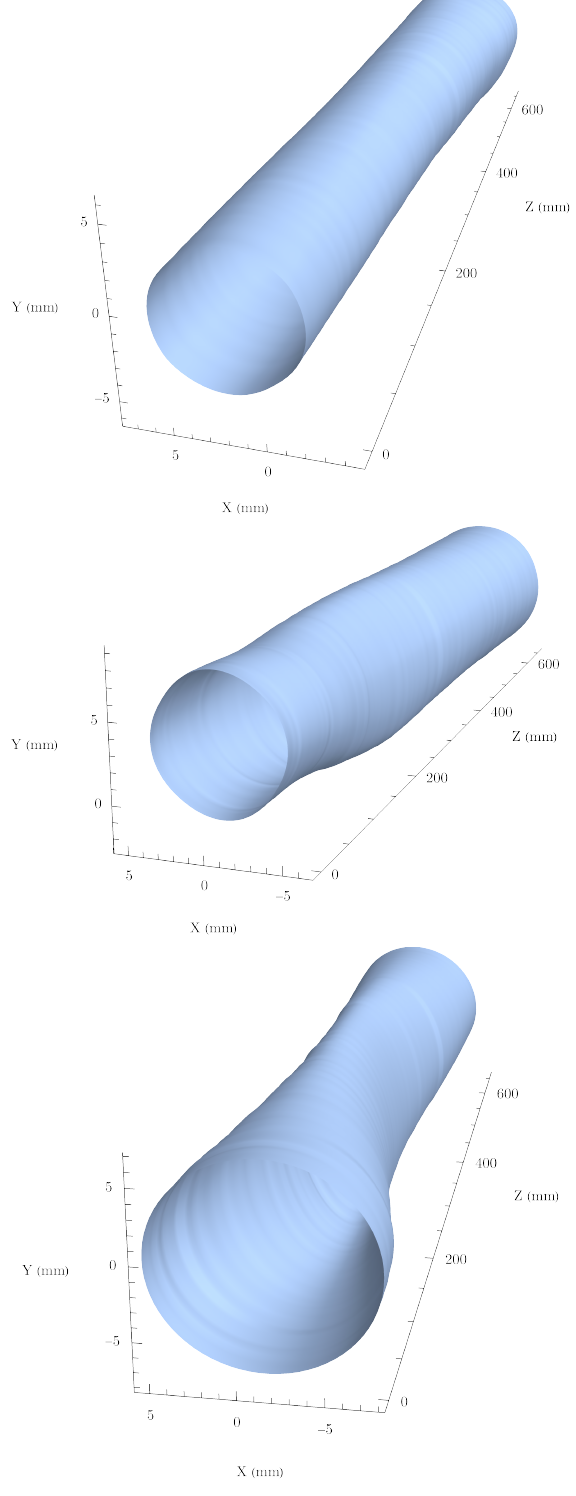
Figure 10. Reconstructed 3D beam envelope, for the three different cases: MBL magnets off ( top ); a focused beam entering the MBL with magnets on ( center ); a flat beam entering the MBL ( bottom